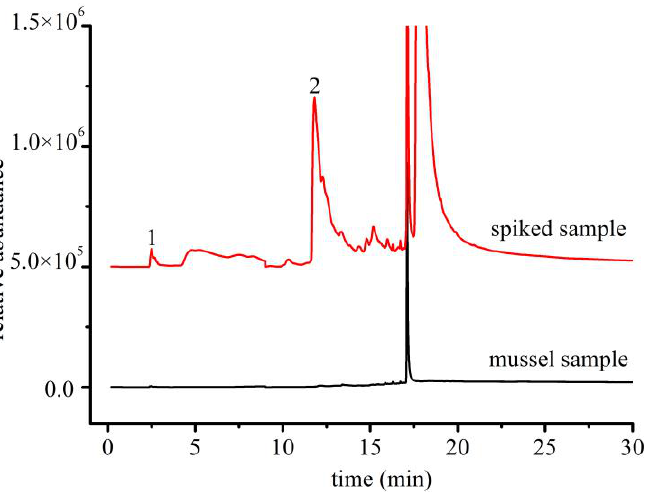
Figure 10. Selected ion chromatograms of mussel samples (concentration, 20 μg/g) (1: cyclopentanone; 2: caprolactam).